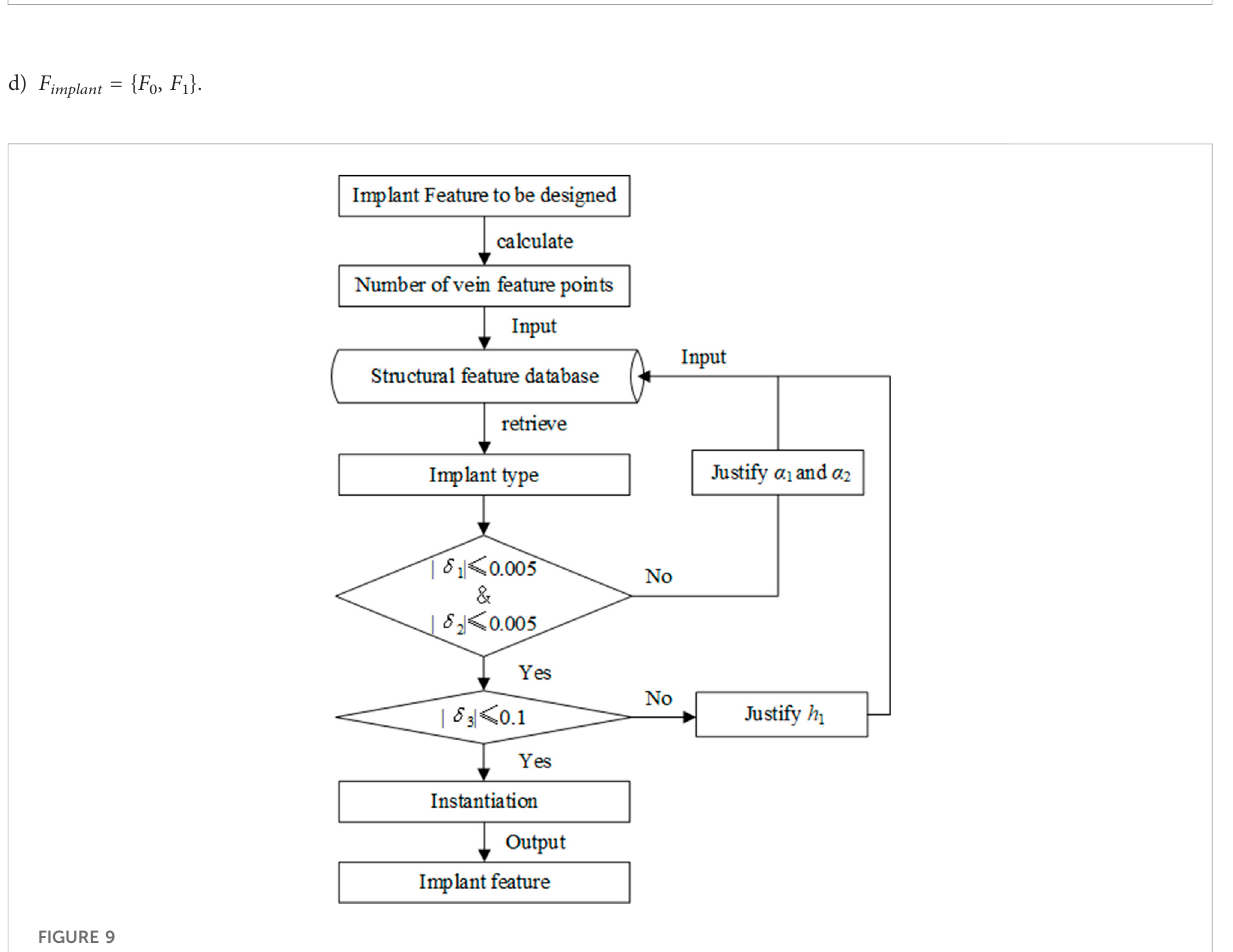
FIGURE 9 Bionic vein structure retrieval